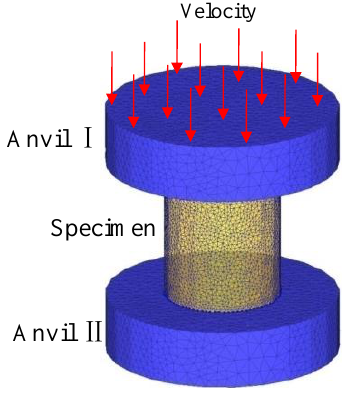
Figure 11. The finite element model for the simulated isothermal compression tests of Inconel 718 superalloy.